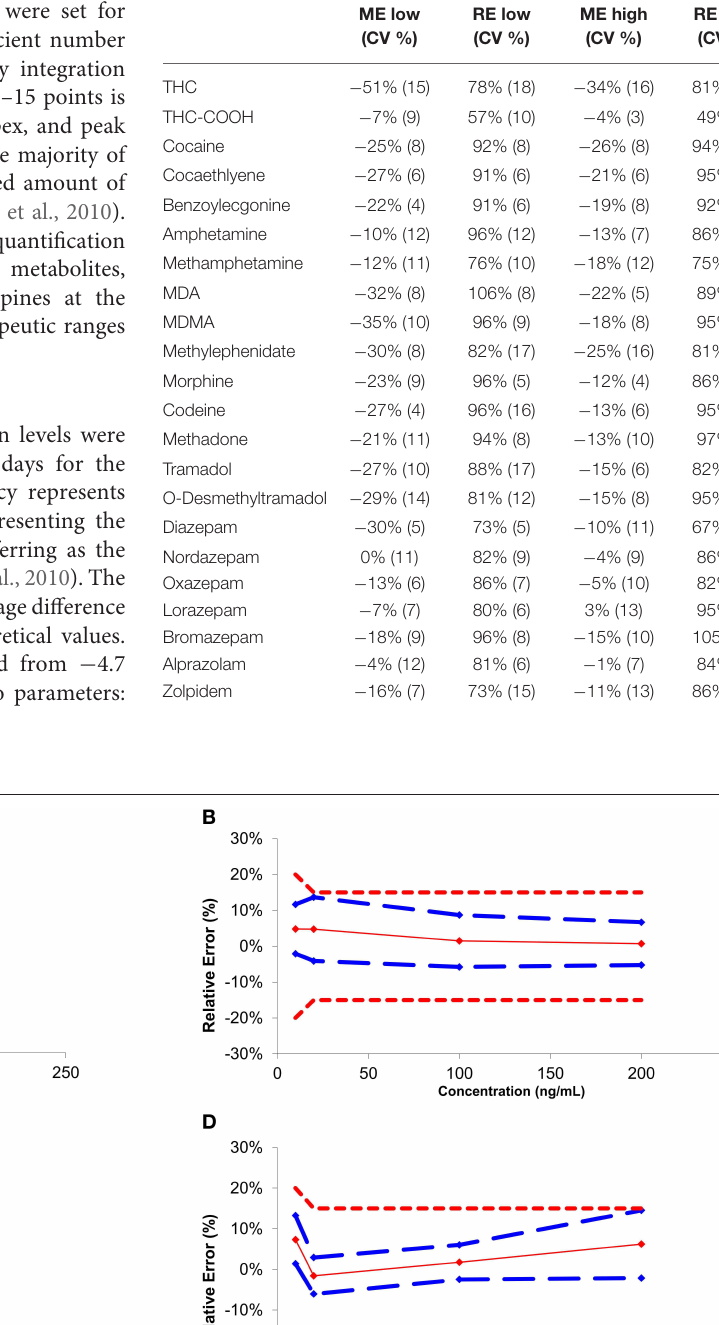
TABLE 3 | Results for Recovery and Matrix Effect performed at low- and high-quality control concentrations. Matrix effect and recovery